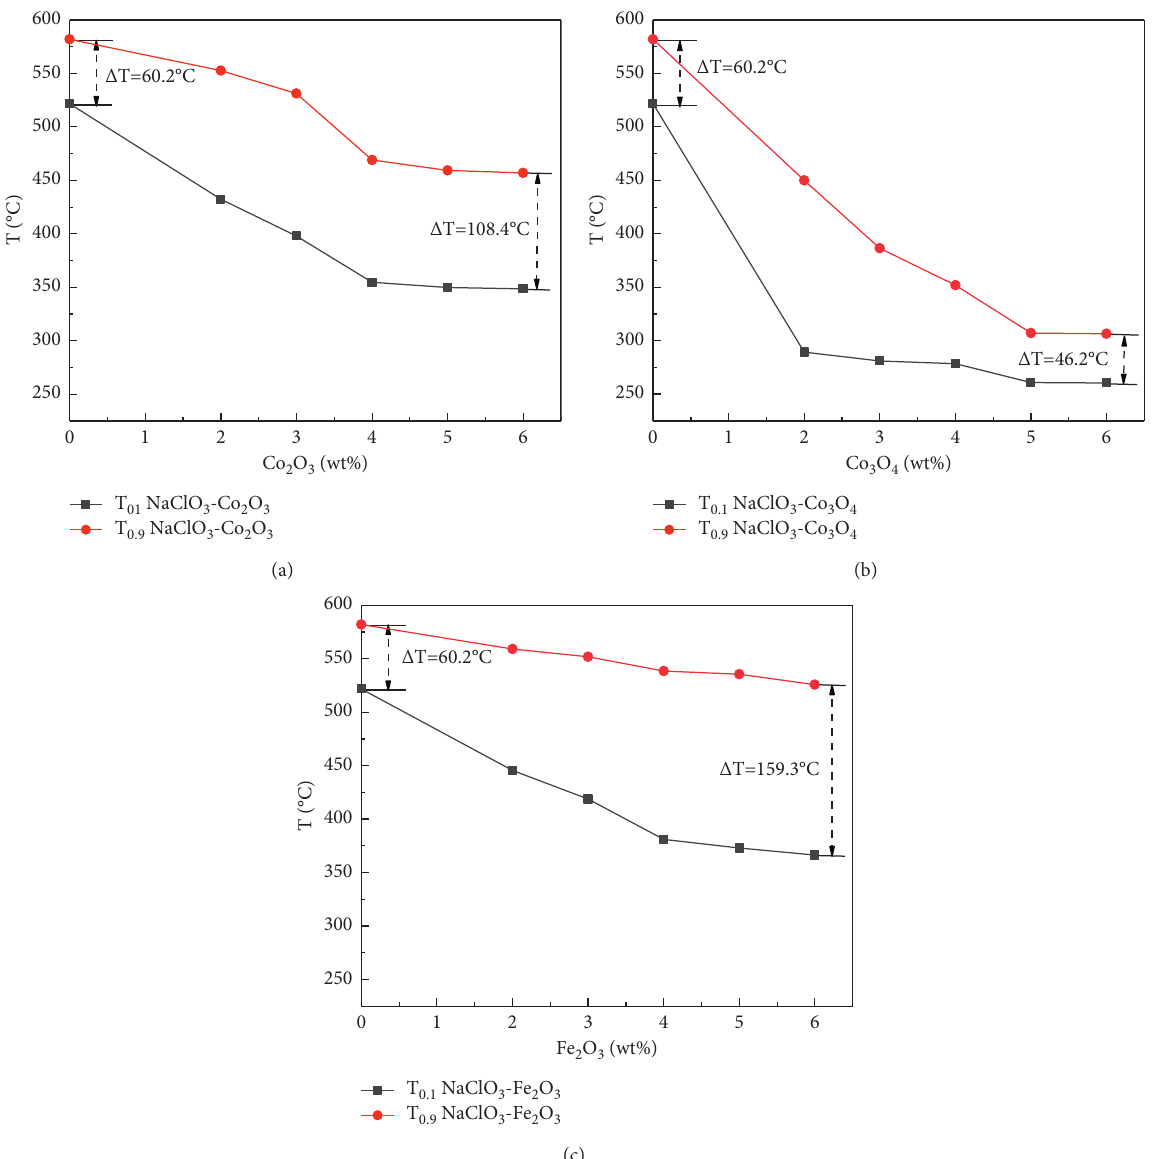
Figure 6: NaClO 3 oxide pyrolysis characteristic temperature curve. (a) NaClO 3 –Co 2 O 3 pyrolysis characteristic temperature curve. (b) NaClO 3 –Co 3 O 4 pyrolysis characteristic temperature curve. (c) NaClO 3 –Fe 2 O 3 pyrolysis characteristic temperature